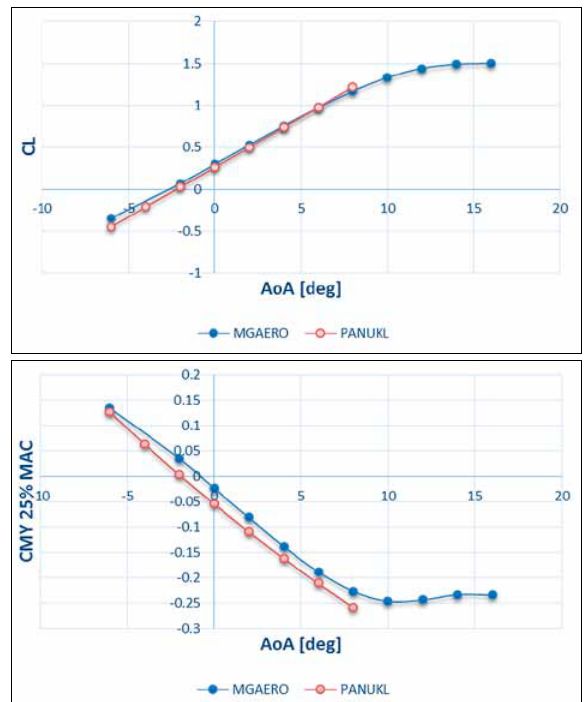
Fig. 5. Comparisons of the lift coefficient and pitching moment coefficient with respect to 25% of the MAC computed by PANUKL and MGAERO